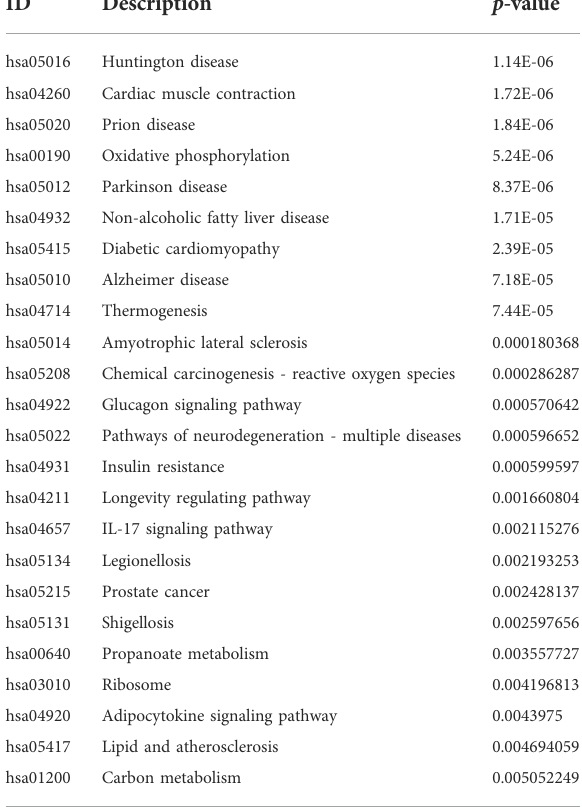
TABLE 2 KEGG enrichment